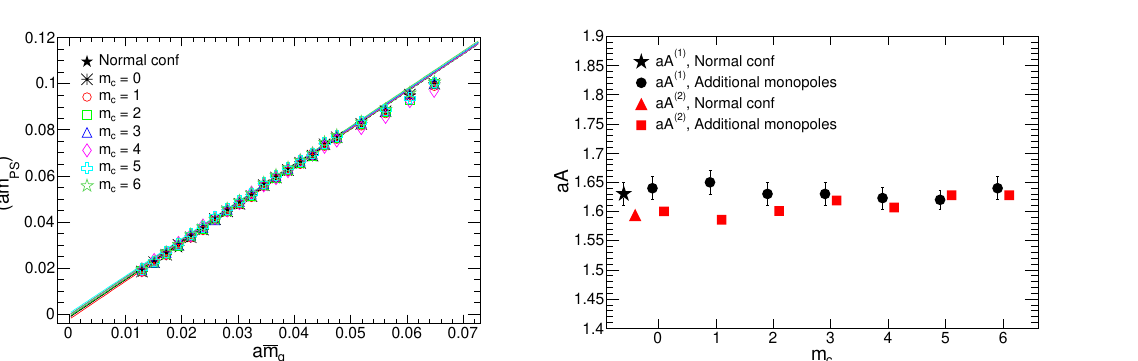
Table 10 . The (cid:12)tting results of the slopes aA (1) and aA (2) and the intercept a 2 B . The numerical results of the renormalization constant ^ Z S .